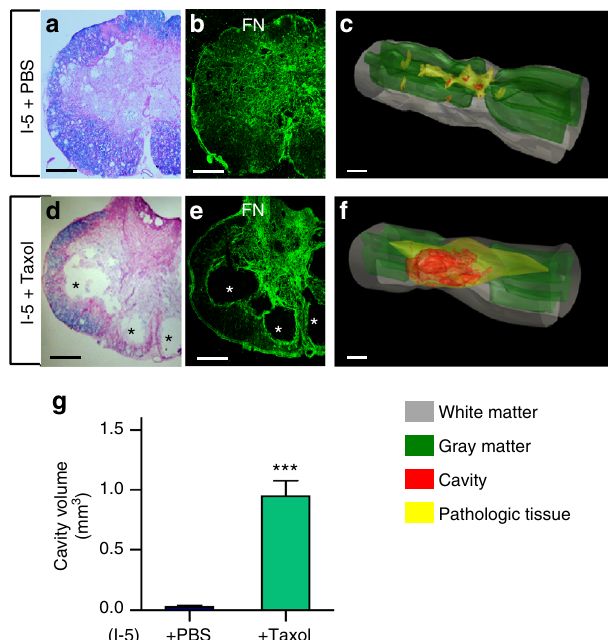
Fig. 5 Taxol results in expansion of cystic cavities. a , d Representative images of transverse spinal cord sections stained with eriochrome cyanine and eosin from animals with I-5 mixed with PBS ( a ) or Taxol ( d ). Adjacent sections were stained with antibodies against FN ( b , e ). Asterisks indicate cystic cavities. Scale bars represent 200 μ m. c , f Representative 3D reconstruction images of the spinal cord tissue from animals with I-5 mixed with PBS ( c ) or Taxol ( f ). Scale bars represent 1 mm. g Quanti fi cation graph of cavity volume. *** indicates p < 0.001 by two-tailed Student ’ s t -test. N = 4 for each group. Error bars represent the